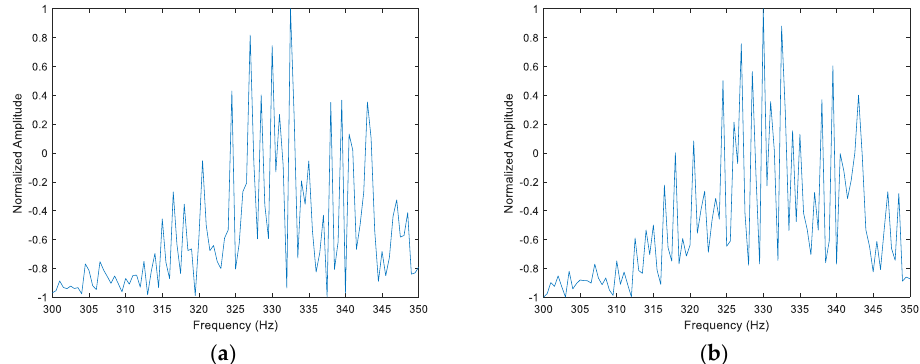
Figure 7. The features of two samples of the experimental data, where the horizontal axis represents the frequency from 300 to 350 Hz and the vertical axis is the normalized amplitude from − 1 to 1: ( a ) the 1st features of the experimental source; ( b ) the 1496th features of the experimental source.